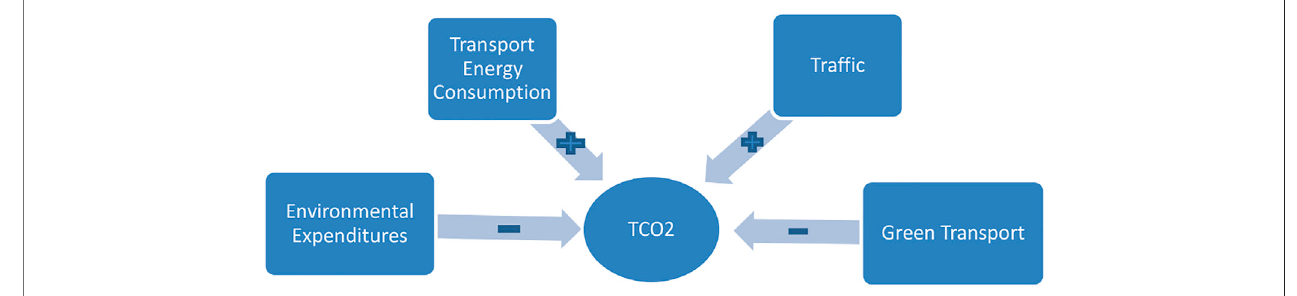
FIGURE 1 | Theoretical